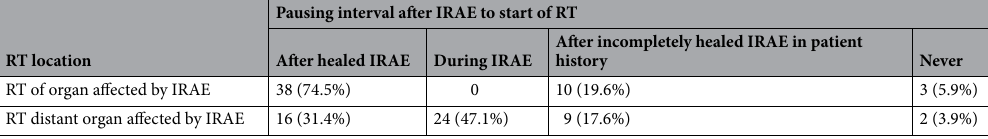
Table 5. Practical handling and pausing intervals after an immune related adverse event (IRAE) until the start of radiotherapy (RT) depending of the location of RT (N = 51).